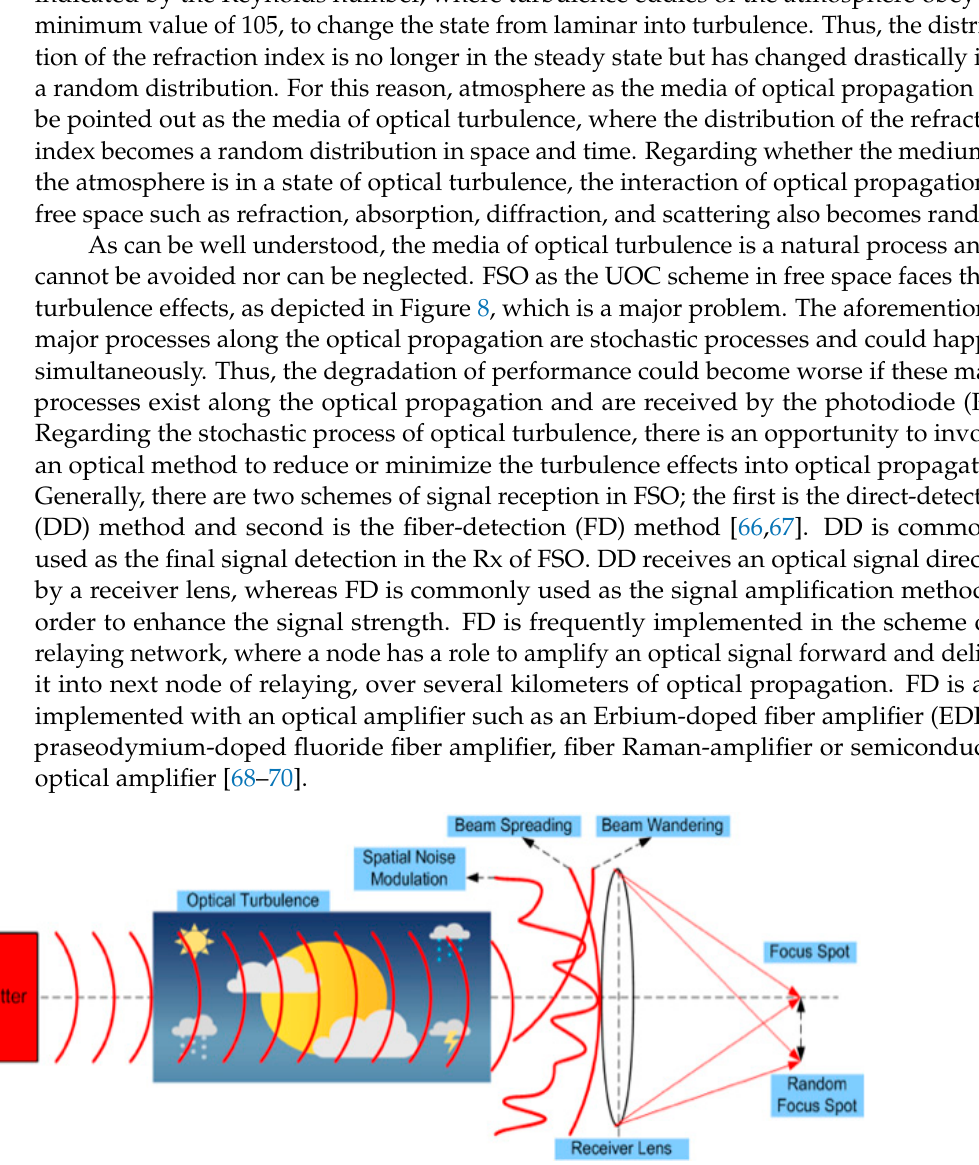
Figure 8. The optical propagation induced by optical turbulence leads to beam wandering, beam spreading, and spatial noise modulation and the focus spot becomes random around the optical axis.